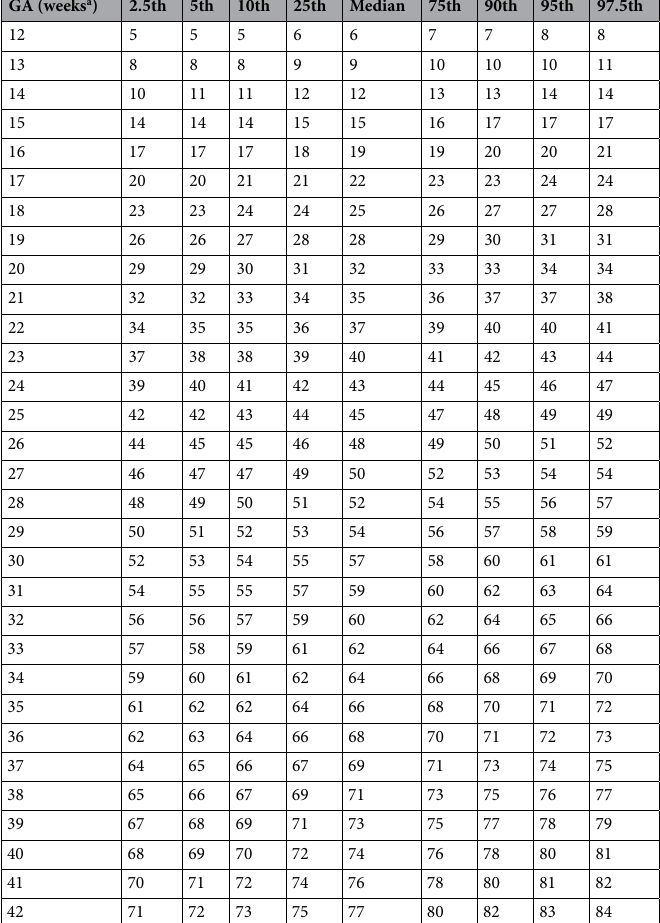
Table 11. Estimated femur length (FL) in mm by gestational age (GA) for males and females, percentiles. a GA expressed as completed gestational weeks, e.g. 12 weeks corresponds to 12 + 0 weeks or 84 gestational